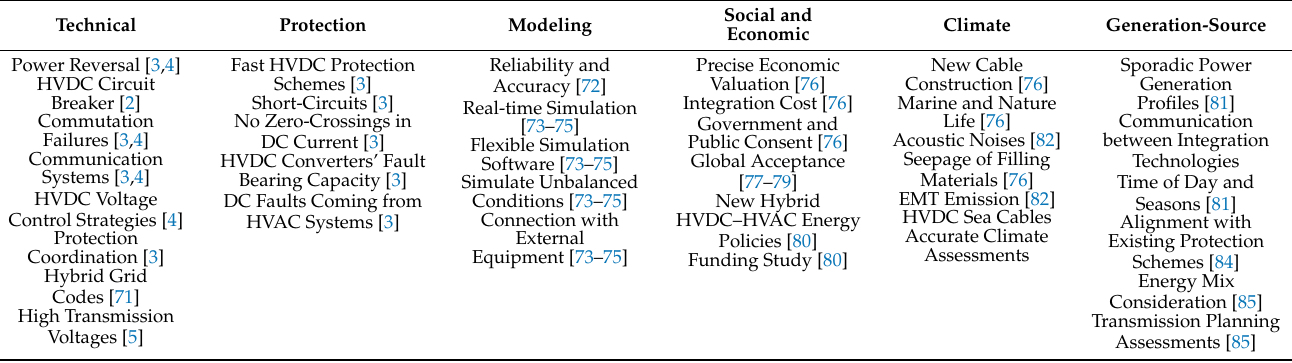
Table 4. Integration challenges of hybrid HVAC–HVDC